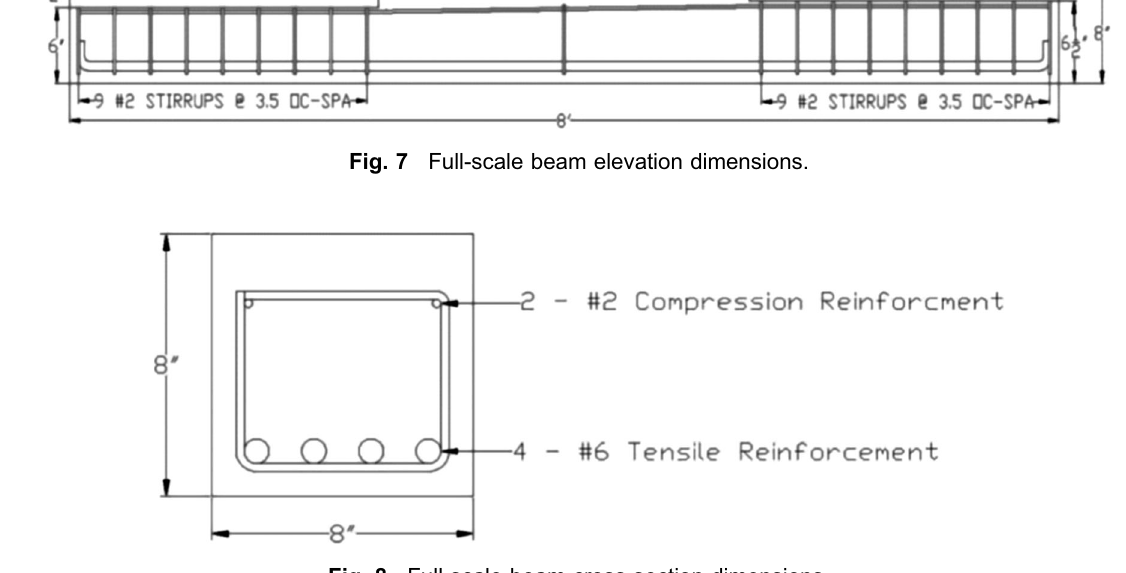
Fig. 8 Full-scale beam cross-section dimensions.